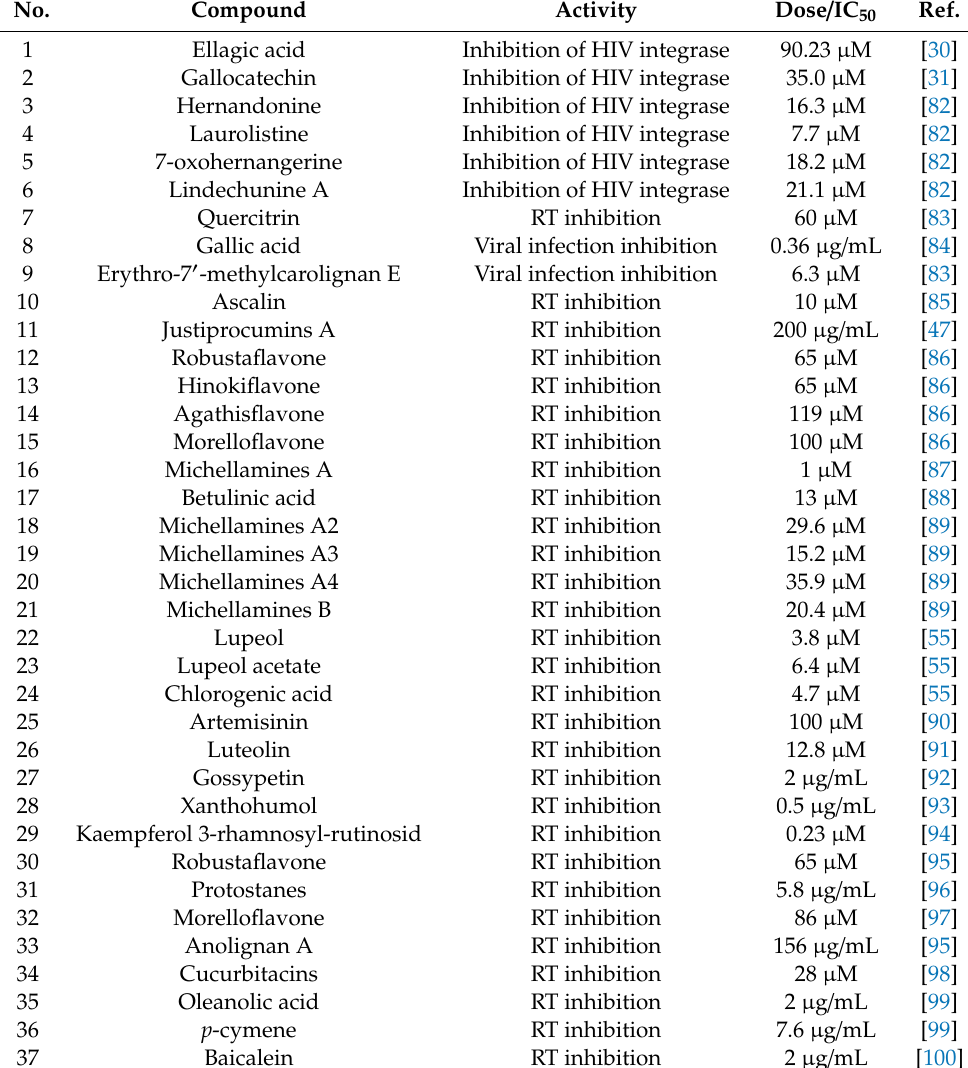
Table 2. Bioactive compounds derived from plants with anti-HIV